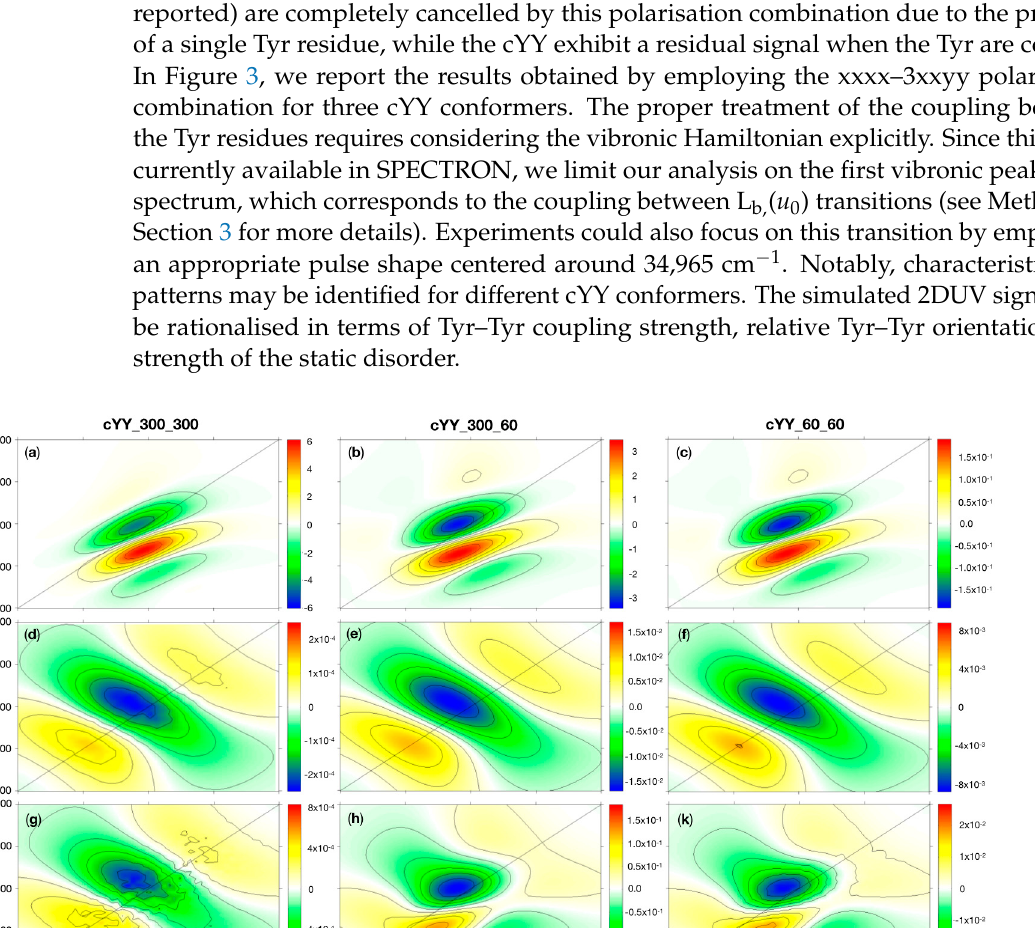
Table 2. Analysis of 2DUV data reported in Figure 3 for the three systems cYY_300_300,